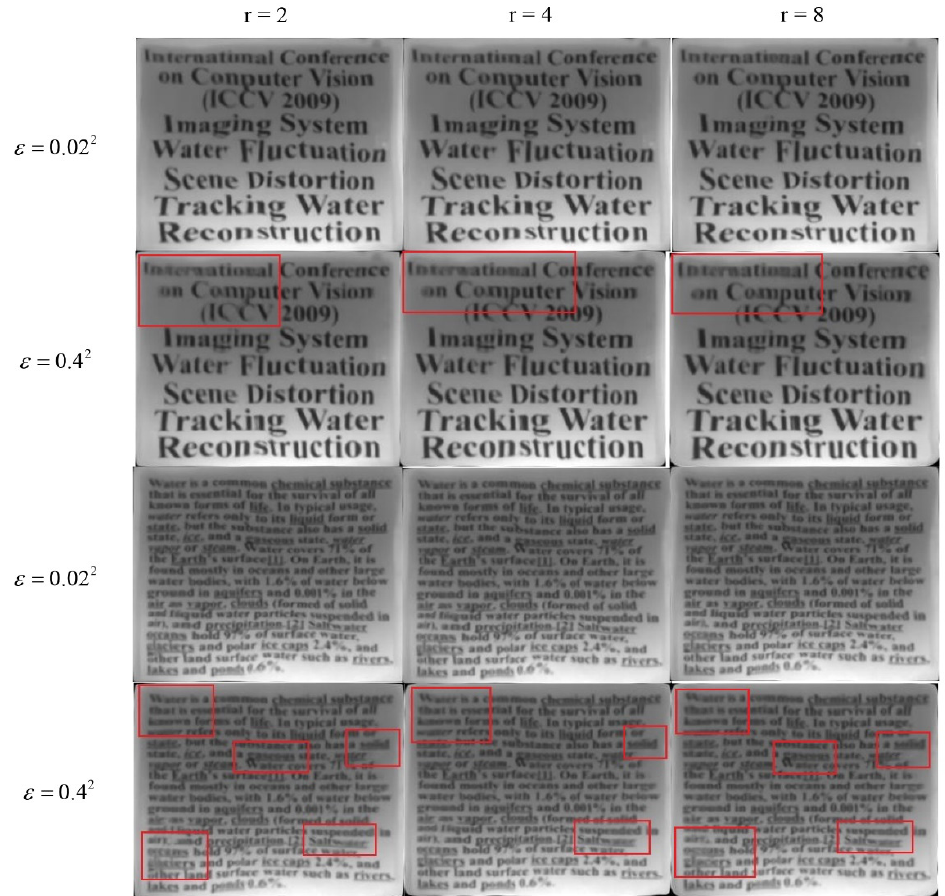
Figure 6. The results of the proposed method with different combinations of ε and r . The blurred regions are marked with red rectangles.